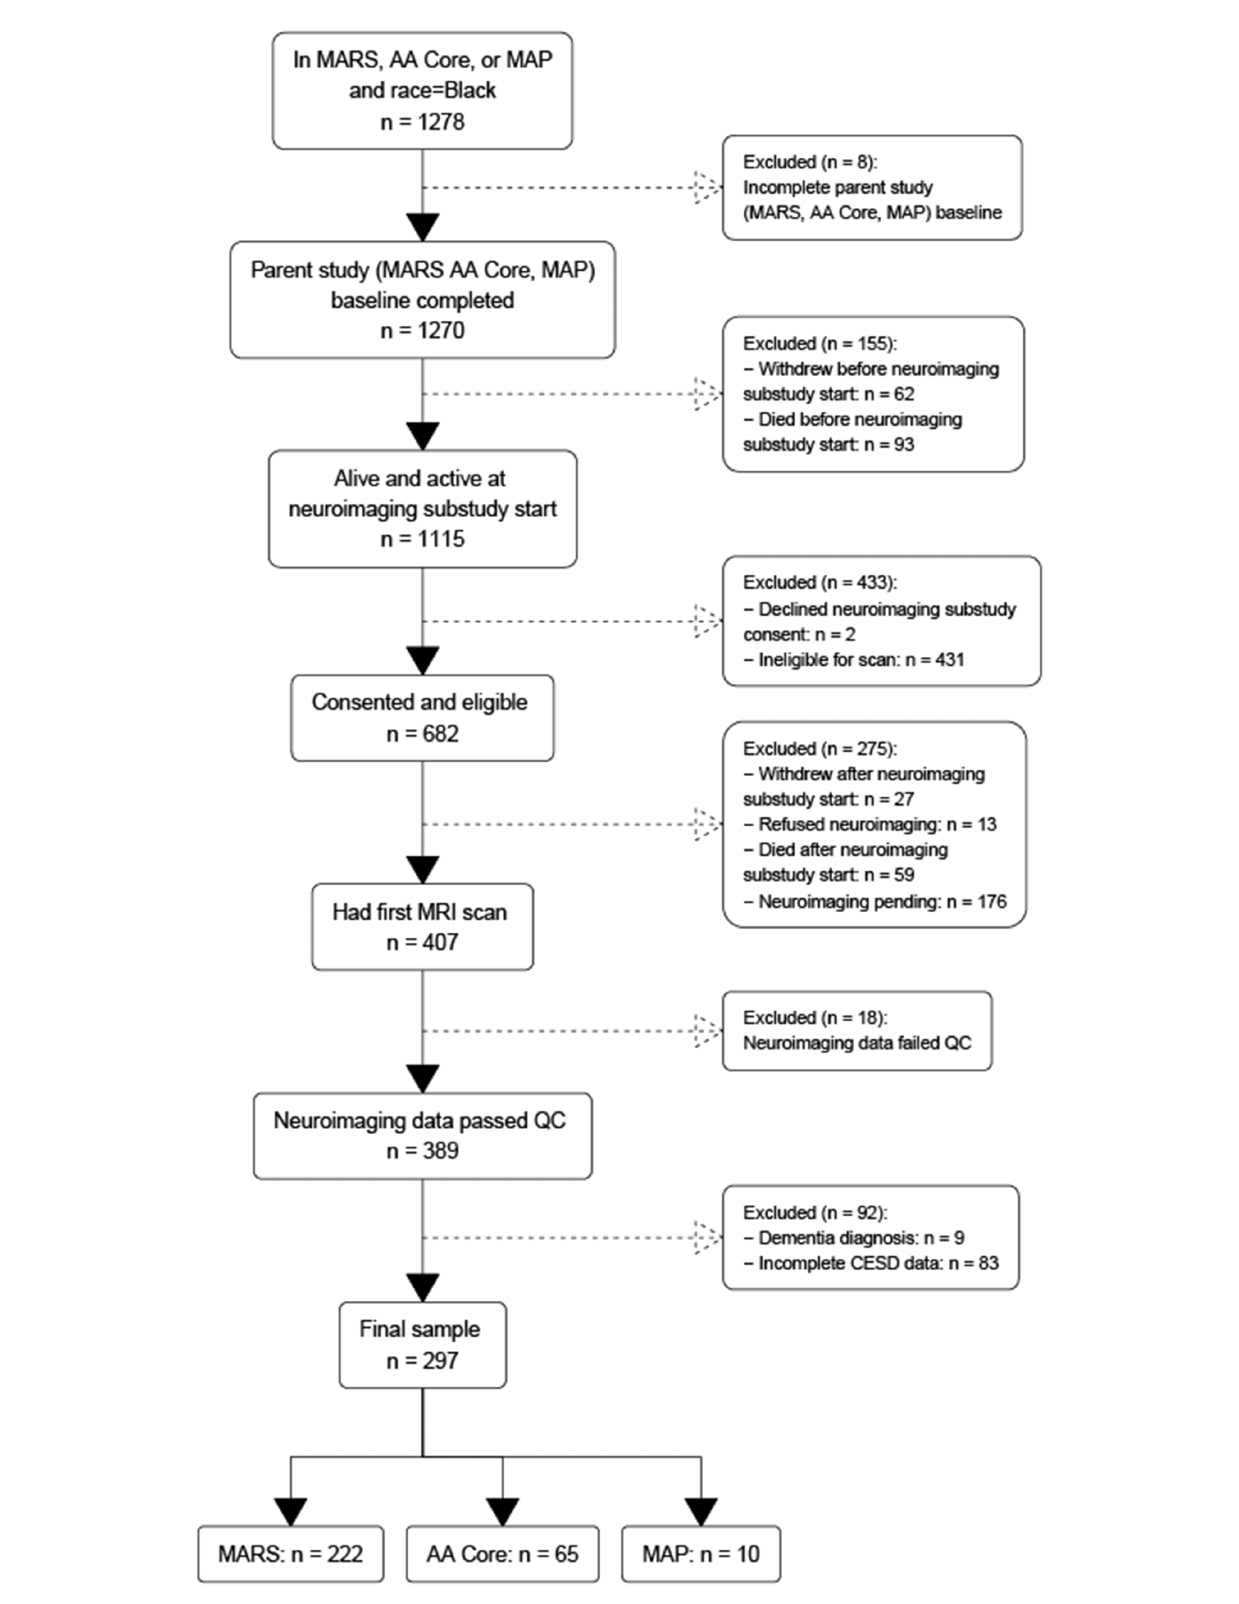
FIGURE 1 Flowchart of participant recruitment across three parent epidemiological studies of aging and dementia conducted in the United